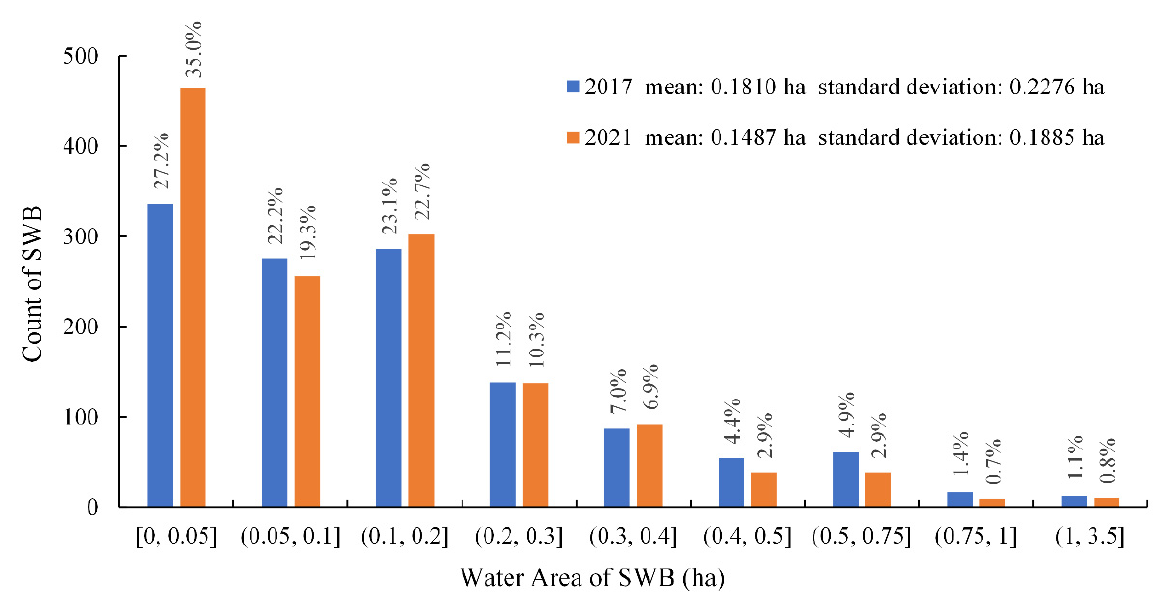
Figure 6. The count and area of the selected small water bodies (SWBs) in the study region in 2017 and 2021.